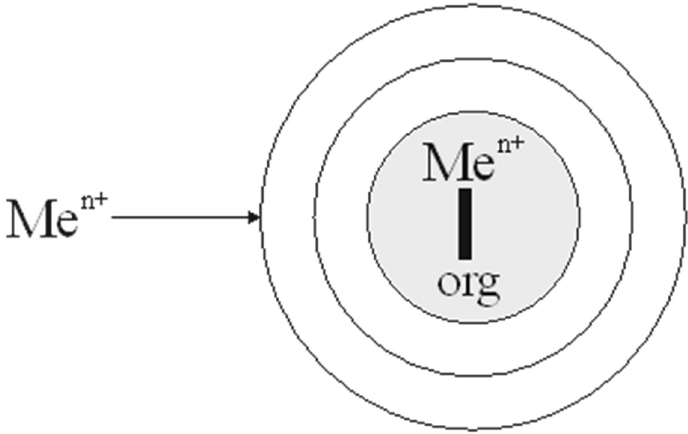
Figure 1. An example of bioaccumulation [1].